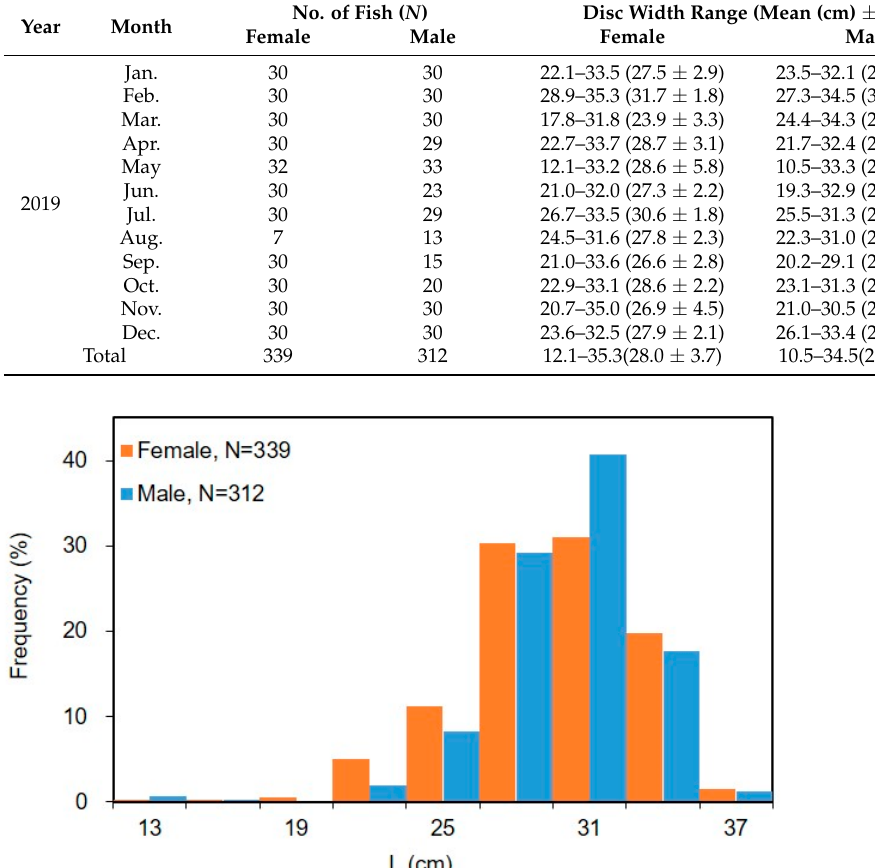
Figure 4. Frequency distribution of disc width measurements of Okamejei kenojei collected from the West Sea of South Korea.